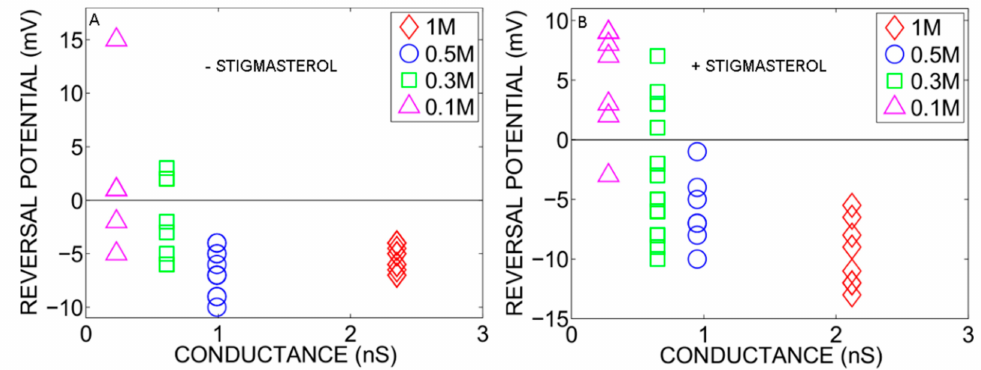
Figure 4. Effect of the ionic strength on the single-channel selectivity. The reversal potential was measured in the presence of constant ion concentration ratio of [KCl] Trans /[KCl] Cis = 10. The ion concentration in the Trans compartment is shown in the insert. The reversal potential of each single-PcVDAC studied is plotted as a function of the average single-channel conductance determined for each ionic strength. The membrane was either free of stigmasterol ( A ) or doped with 10% stigmasterol ( B ). The solutions were buffered at pH 7.5 with 10 mM HEPES-KOH.